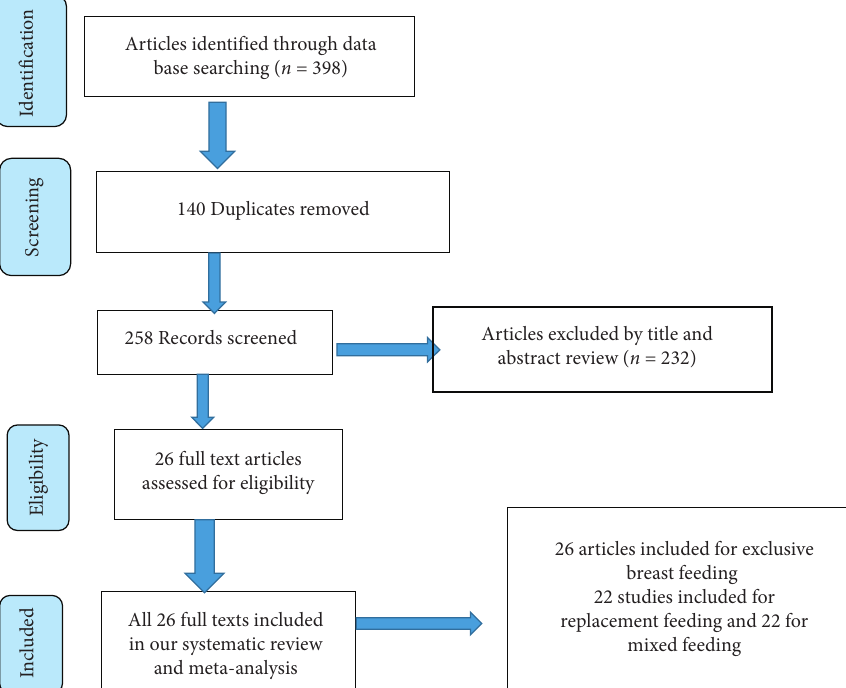
Figure 1: PRISMA flow diagram of included studies to estimate the pooled prevalence of HIV-exposed infant feeding practices in